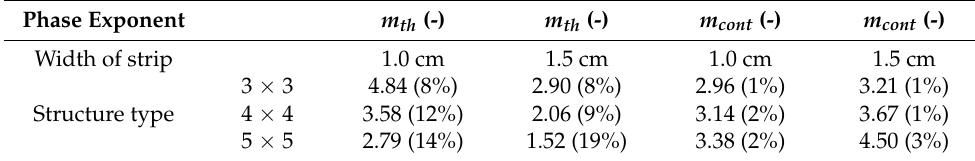
Table 10. The phases’ exponents for designed woven